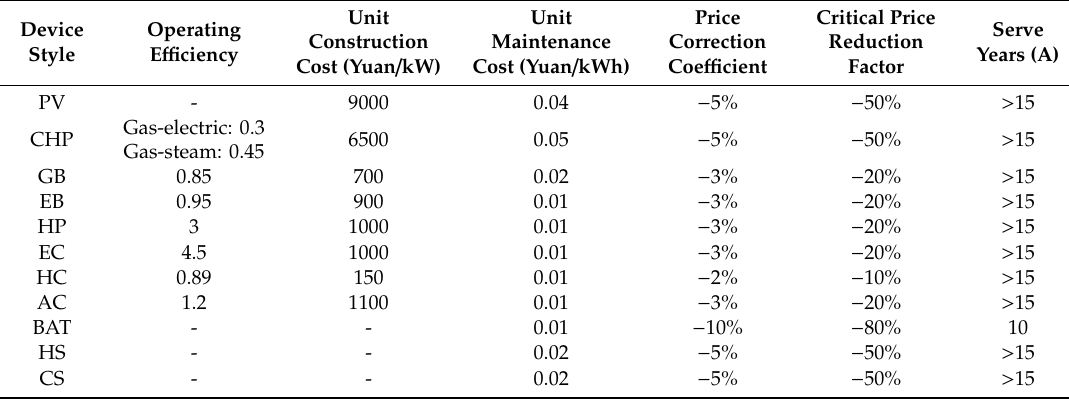
Table 2. Device parameters of IPIES.